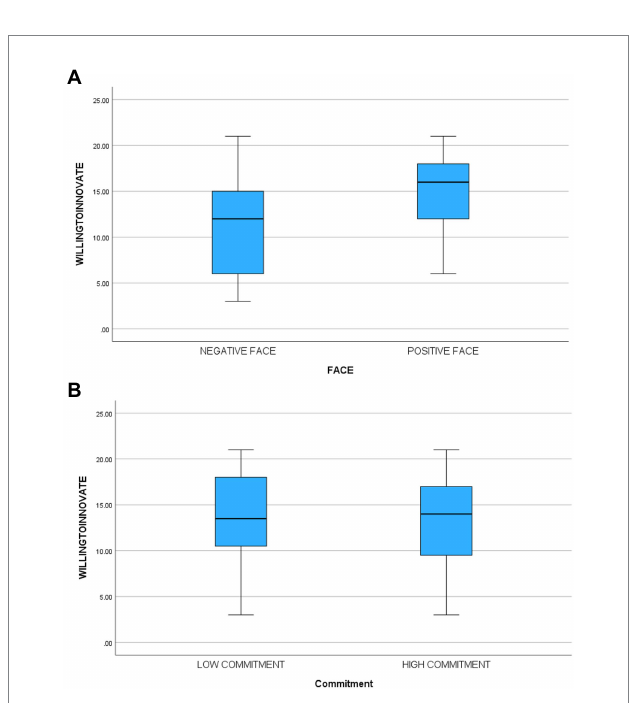
FIGURE 3 (A) Box plot of impact of face threat on willingness to innovate. (B) Box plot of impact of commitment on willingness to innovate.